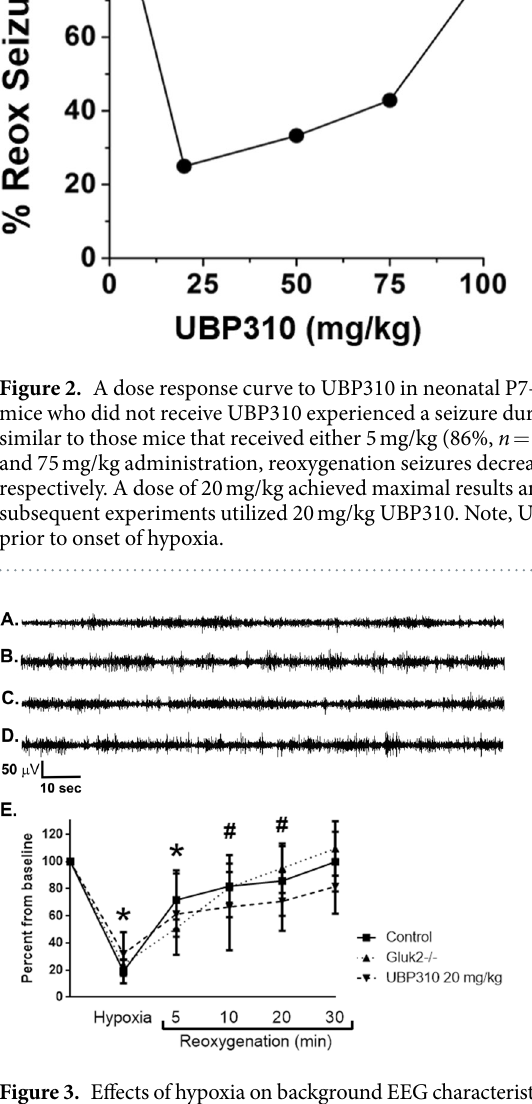
Please see Supplemental Fig. S1 for representative power spectrum analysis from control, GluK2 − / − , and UBP310-treated mice. Of note, seizures during the hypoxic period are clinically evident with rhythmic head and forelimb clonic jerks, while the majority of seizures observed during the reoxygenation period are electrographic